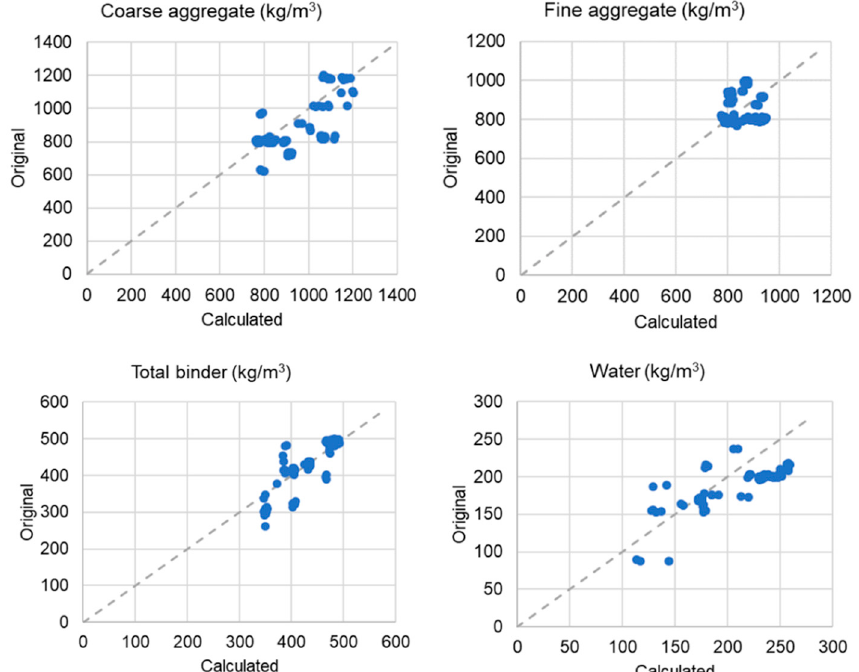
Figure 9. Evaluation of the model’s performance using a validation dataset.